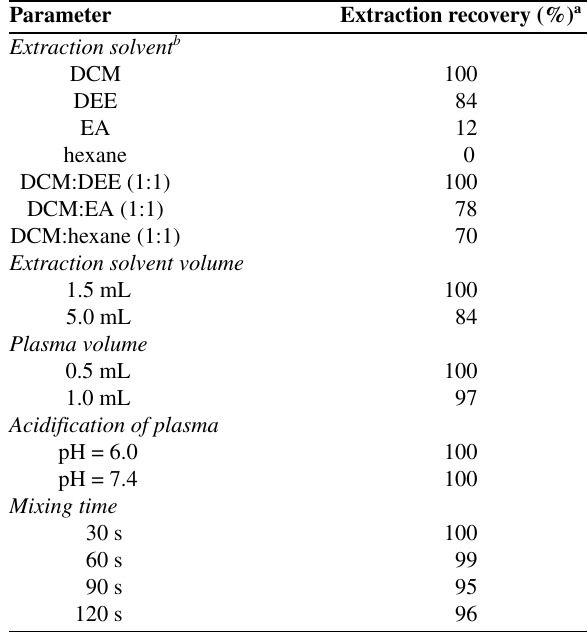
Table 1. Optimization of extraction